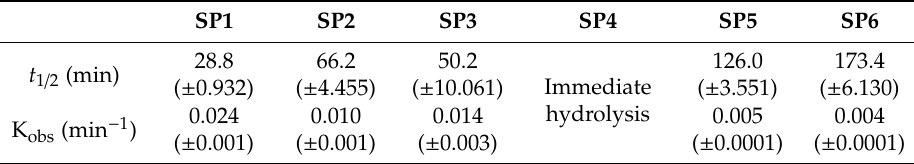
Table 3. Plasma stability studies of